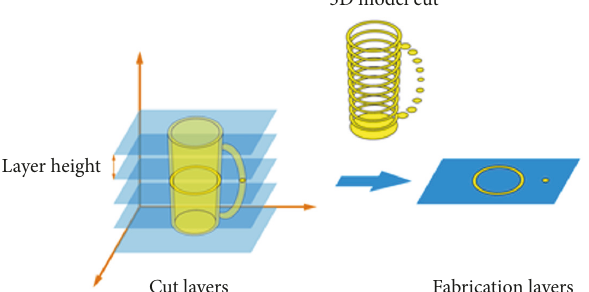
Figure 4: The dispersion-accumulation principle